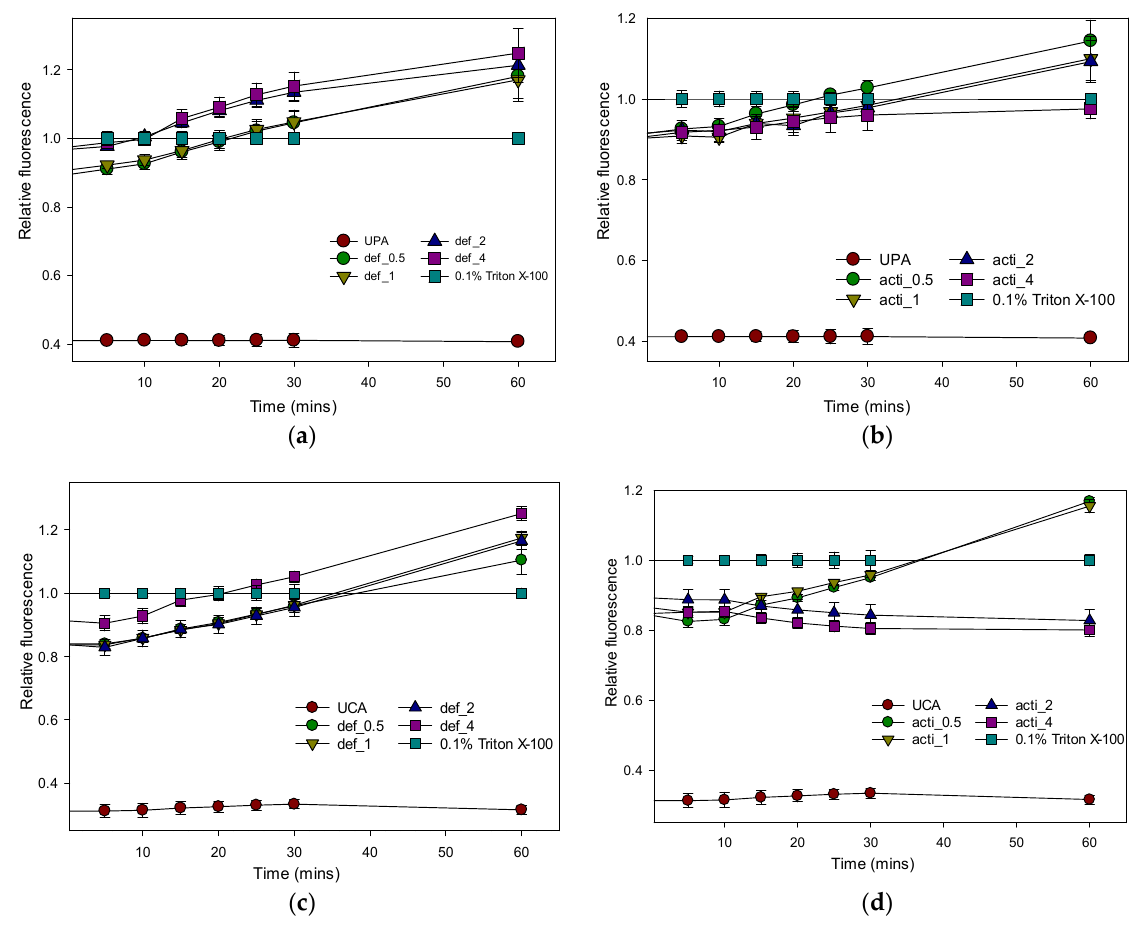
Figure 13. Relative fluorescence of 3-DiSc (5) uptake to assess inner-membrane depolarization of recombinant defensin-d2 and actifensin against P. aeruginosa and C. albicans . ( a ) defensin-treated P. aeruginosa ( b ) actifensin-treated P. aeruginosa ( c ) defensin-treated C. albicans ( d ) actifensin-treated C. albicans . The positive control, 0.1% ( v / v ) Triton-X 100, was used for normalization of fluorescence. UPA—untreated P. aeruginosa ; UCA—untreated C. albicans ; def—defensin-d2; acti—actifensin. Graphs show means and standard error means (as error bars) of triplicate data per treatment.